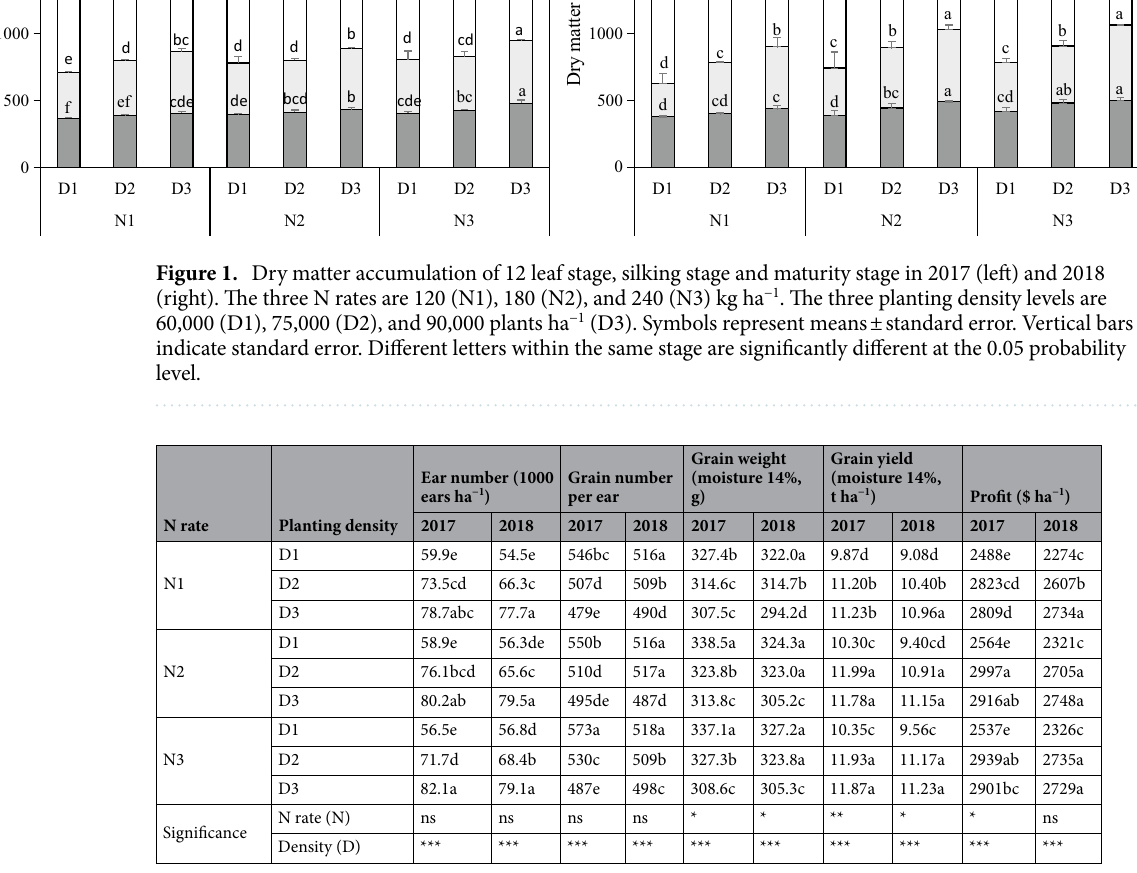
Table 2. Maize ear number, grains per ear, 1000-grain weight, grain yield and profit in 2017 and 2018. ns no significant difference. Means within a column followed by the different letters are significantly different at P < 0.05. N is N rate, and D is planting density. The three N rates are 120 (N1), 180 (N2), and 240 (N3) kg ha −1 . The three planting density levels are 60,000 (D1), 75,000 (D2), and 90,000 plants ha −1 (D3). *Significance at the P < 0.05 level. **Significance at the P < 0.01 level. ***Significance at the P < 0.001